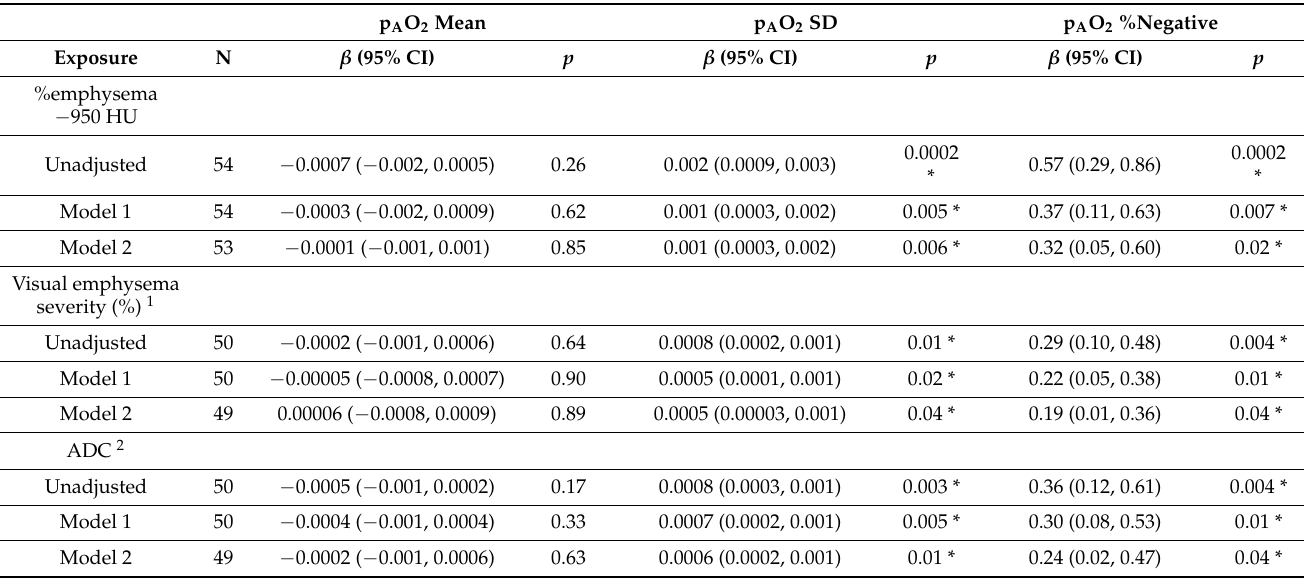
Table 4. Global associations with p A O 2 measures .